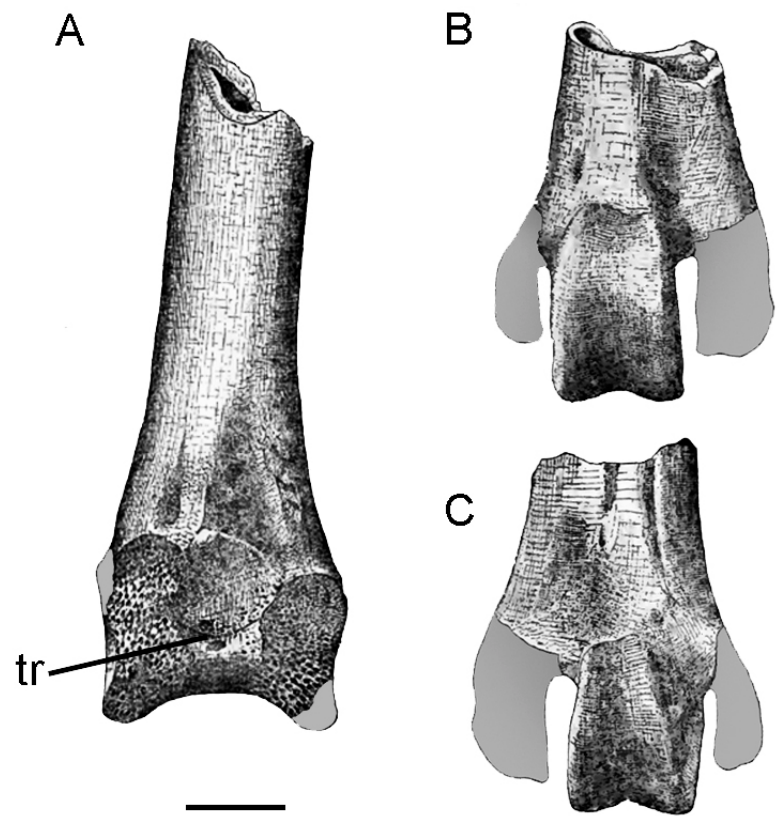
Figure 4. Brontornis burmeisteri ; specimens on which Ameghino [9] based the species Liornis floweri Ameghino, 1895 (NHMUK PV A9058 and NHMUK PV A580). ( A ) right distal half of tibiotarsus in anterior view; ( B , C ) distal end of left tarsometatarsus in ( A ) anterior; and ( B ) posterior views. ( A – C ) modified from Ameghino (1895). Abbreviations . tr, transverse ridge. Scale bar: 5 cm.